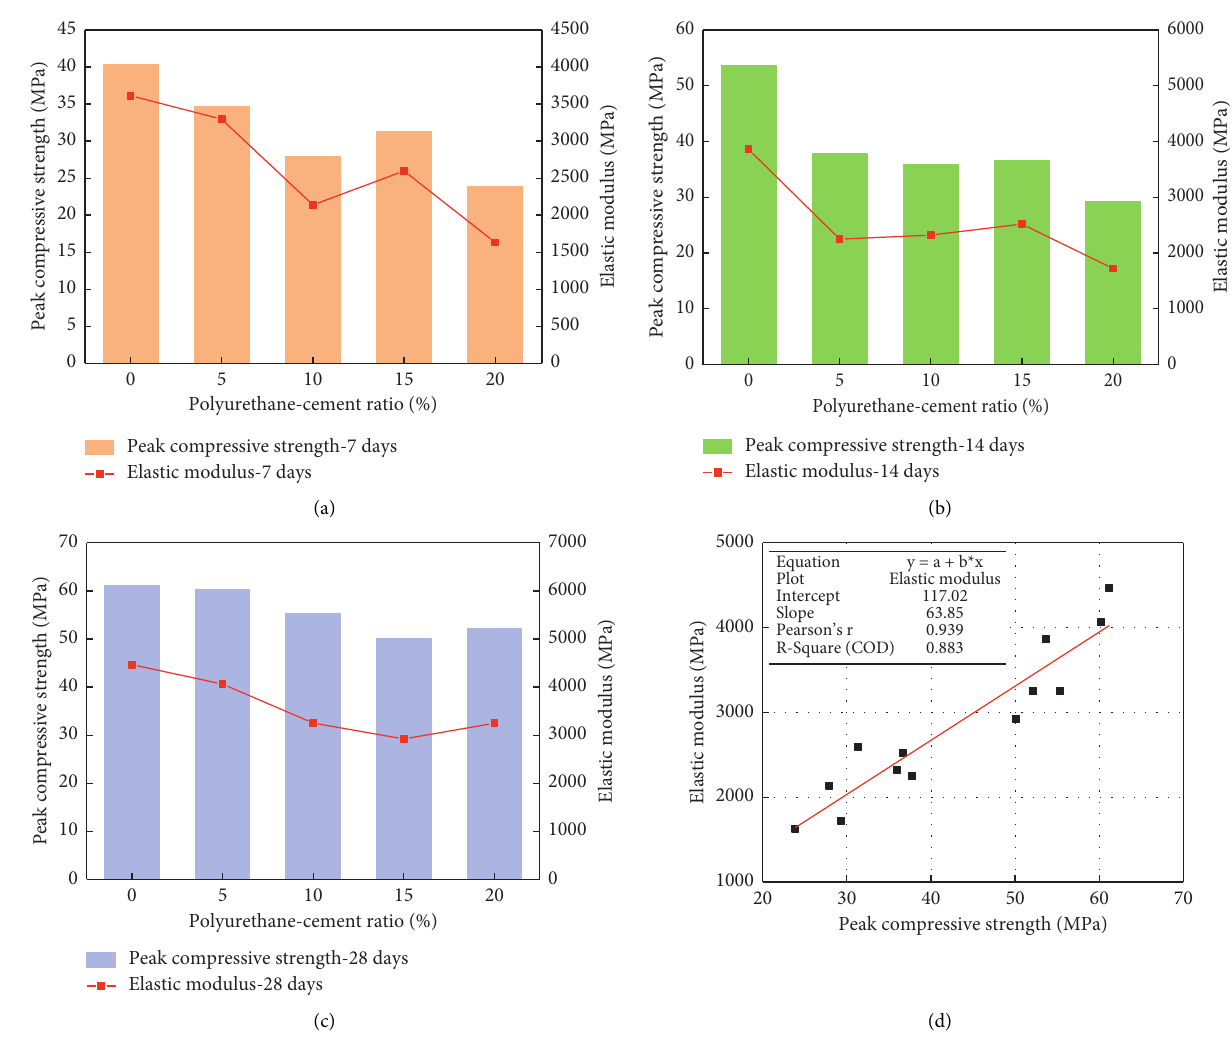
Figure 6: Variations of peak compressive and elastic modulus of PFCBCM composites versus mass content of polyurethane. (a) 7 days. (b) 14 days. (c) 28 days. (d) Fitting